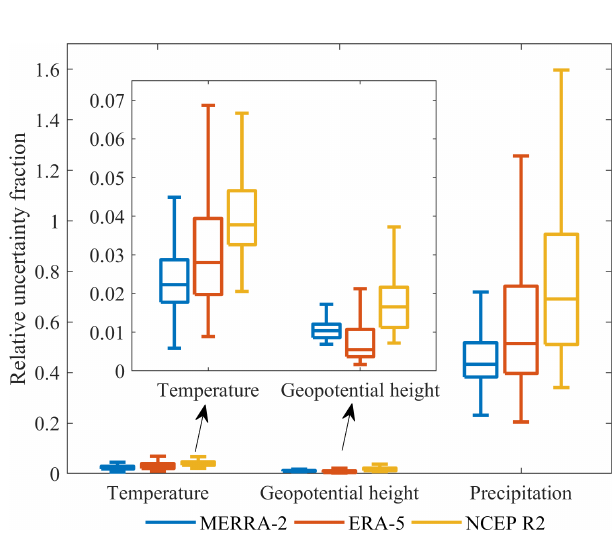
Figure 5. The data uncertainty calculated by the TCH method. The uncertainty distribution is plotted according to the uncertainty over all the pixels of the study